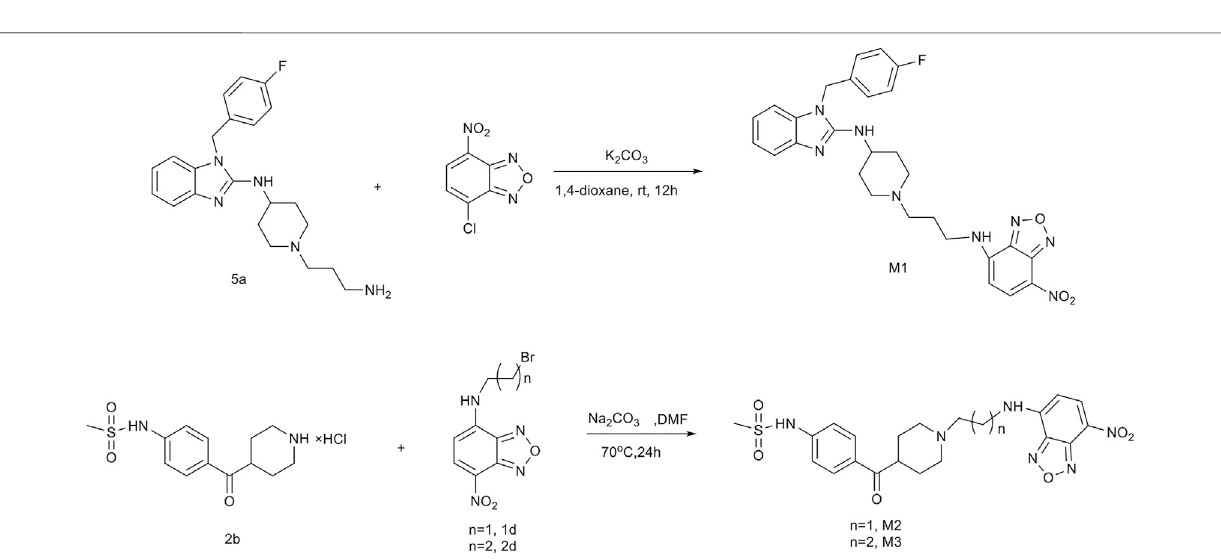
FIGURE 1 | Synthetic routes of fl uorescent probes M1 , M2 , and M3 .